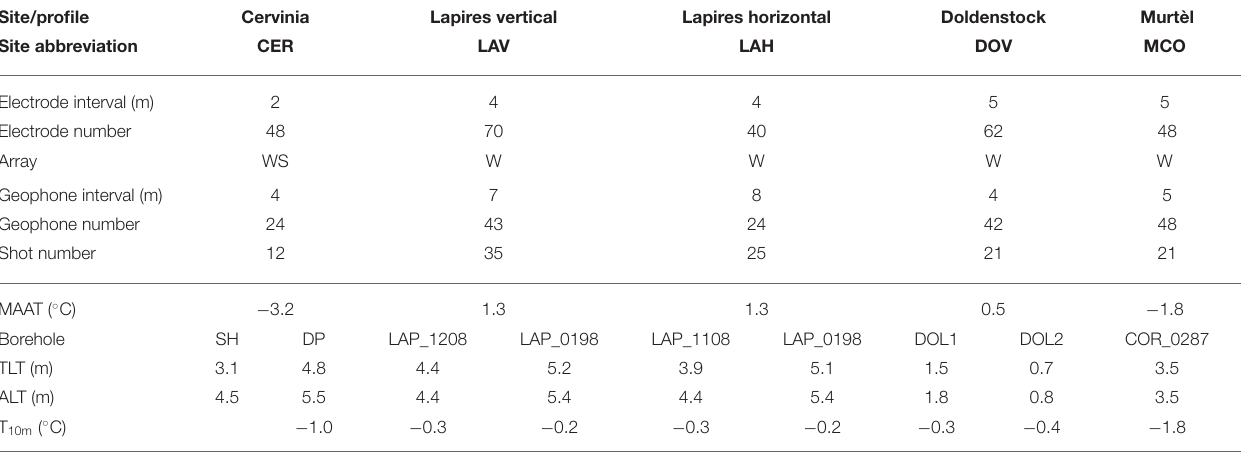
TABLE 1 | Summary of ERT and RST profile set-ups and borehole characteristics.